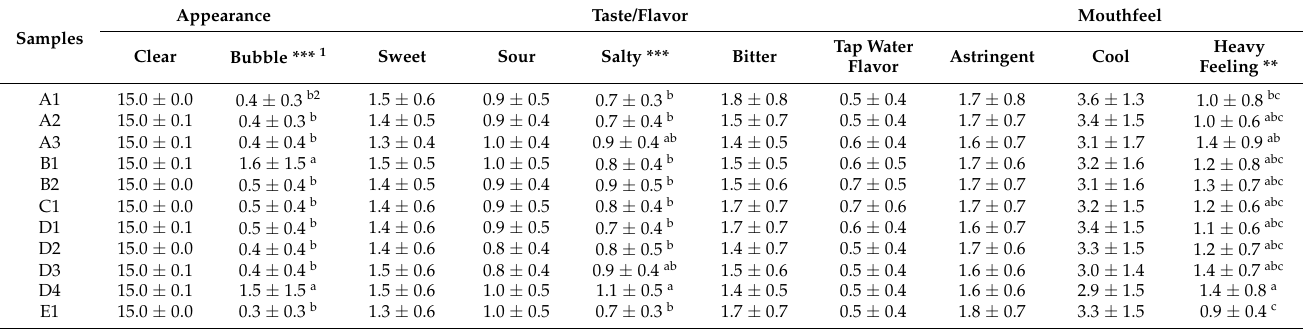
Table 3. Mean intensity ratings of the sensory attributes for 11 water samples 1,2 .